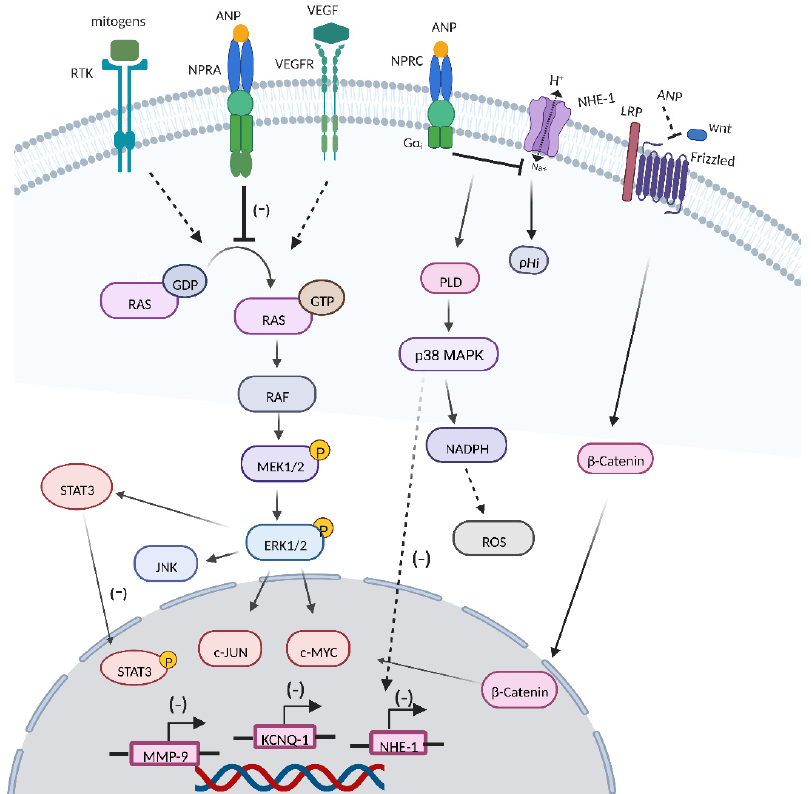
Figure 4. Roles of ANPs in cancer. ANPs exert antineoplastic potential by inhibiting the conversion of GDP-RAS to GTP-RAS, the RAS-MEK1/2-ERK1/2 kinase cascade, and cross-talk between the RAS-MEK1/2-ERK1/2 kinase cascade and VEGF, β -catenin, JNK, WNT, and STAT3. In addition, ANPs also modulate inflammation, ROS production, KCNQ1, and MMP9 expression.